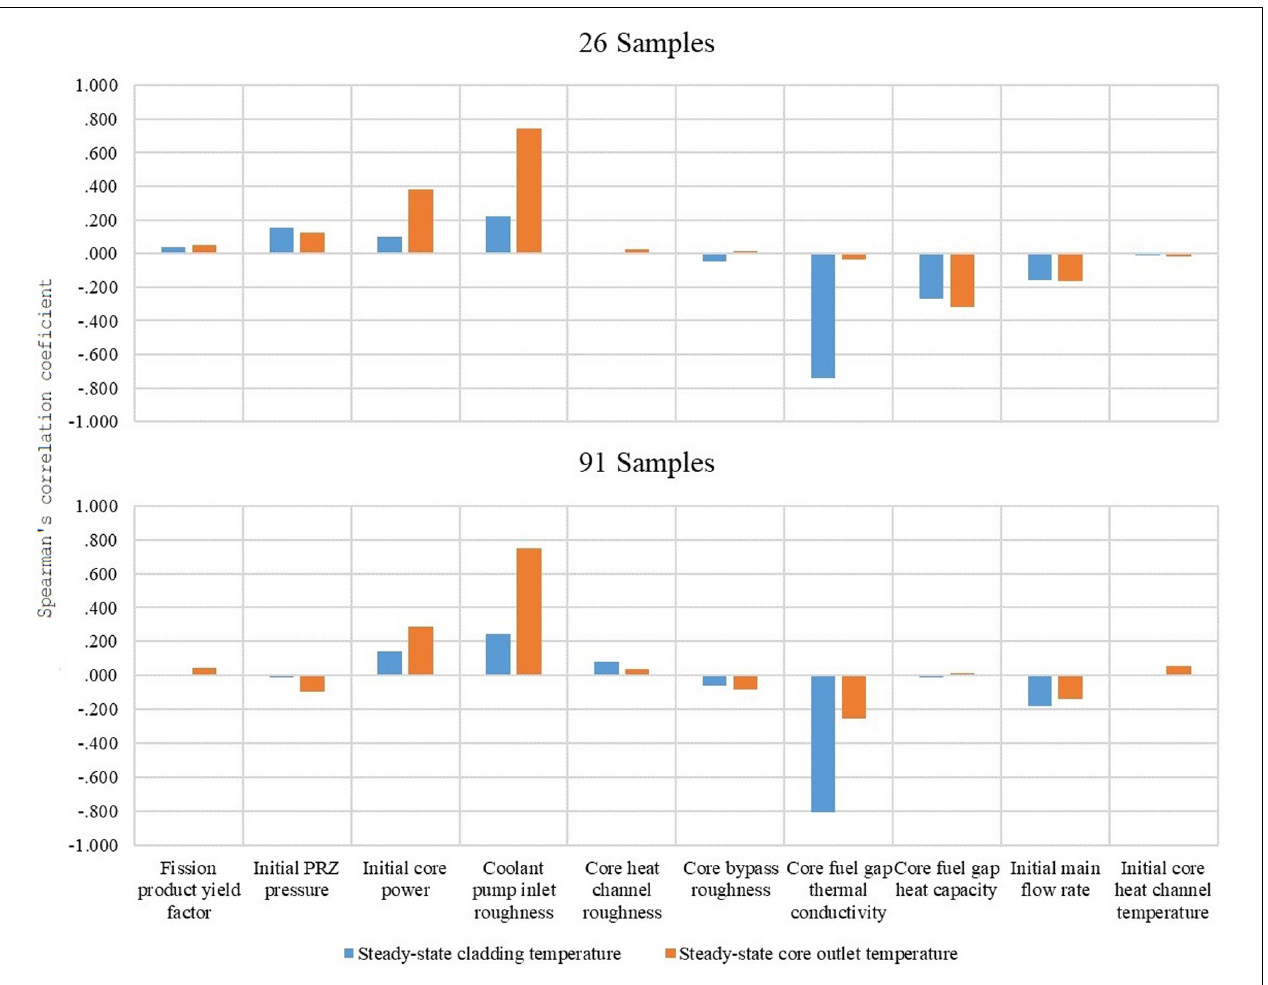
FIGURE 6 | Sensitivity between initialization parameters and steady-state core outlet